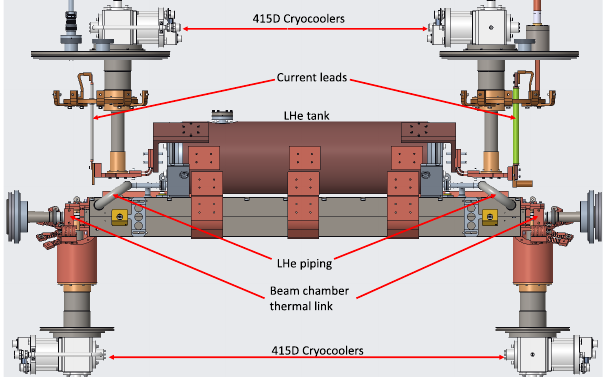
FIG. 20. Cold mass and cryocoolers of the HSCU highlighting the main components of the system. Not shown is the thermal radiation shield and vacuum